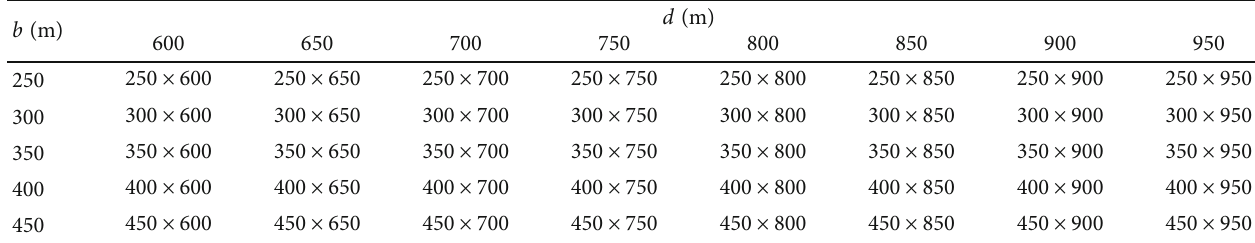
Table 3: Orthogonal experiment design of well spacing (inverted 5-spot well pattern).